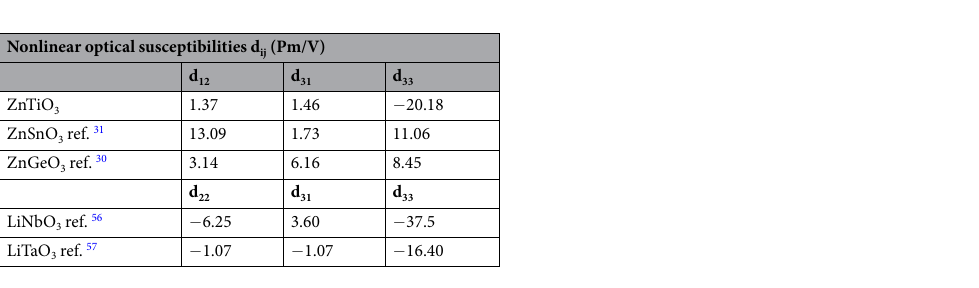
Table 9. The calculated nonlinear optical susceptibilities of LN-type ZnTiO 3